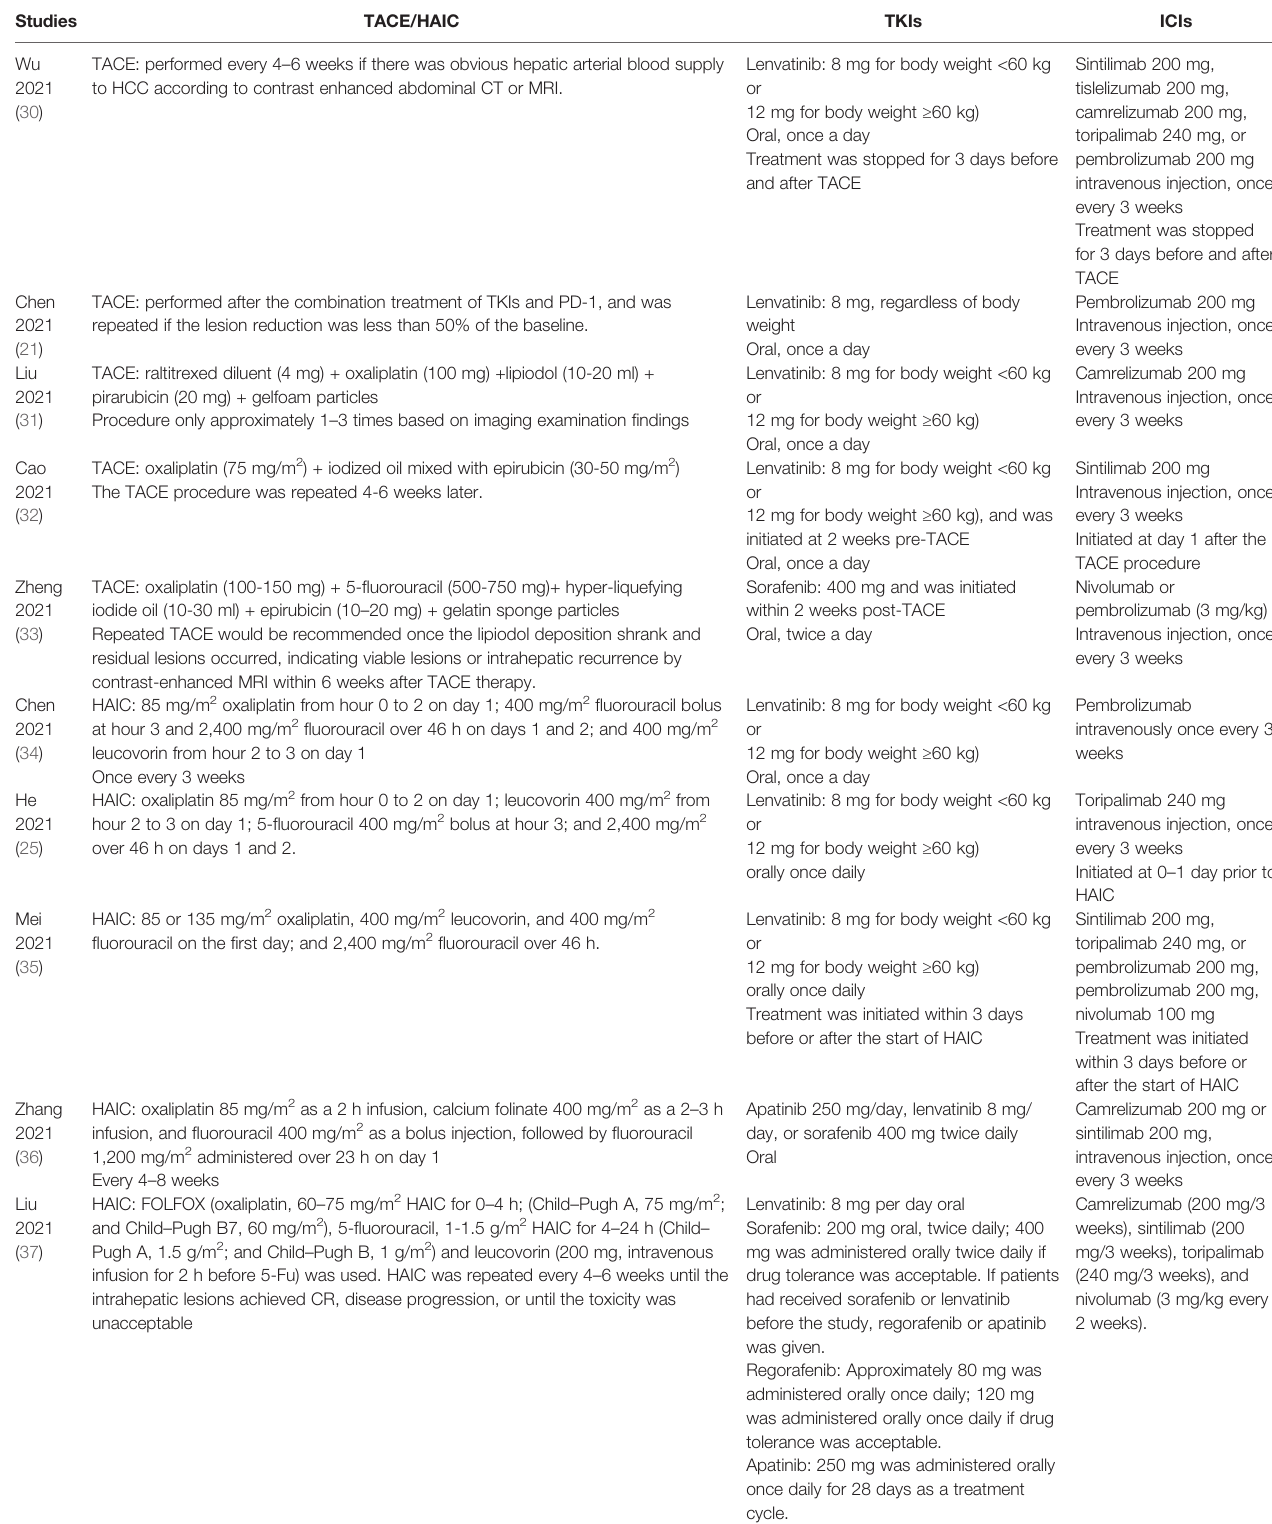
TABLE 2 | Detailed scheme of triple therapy included studies.